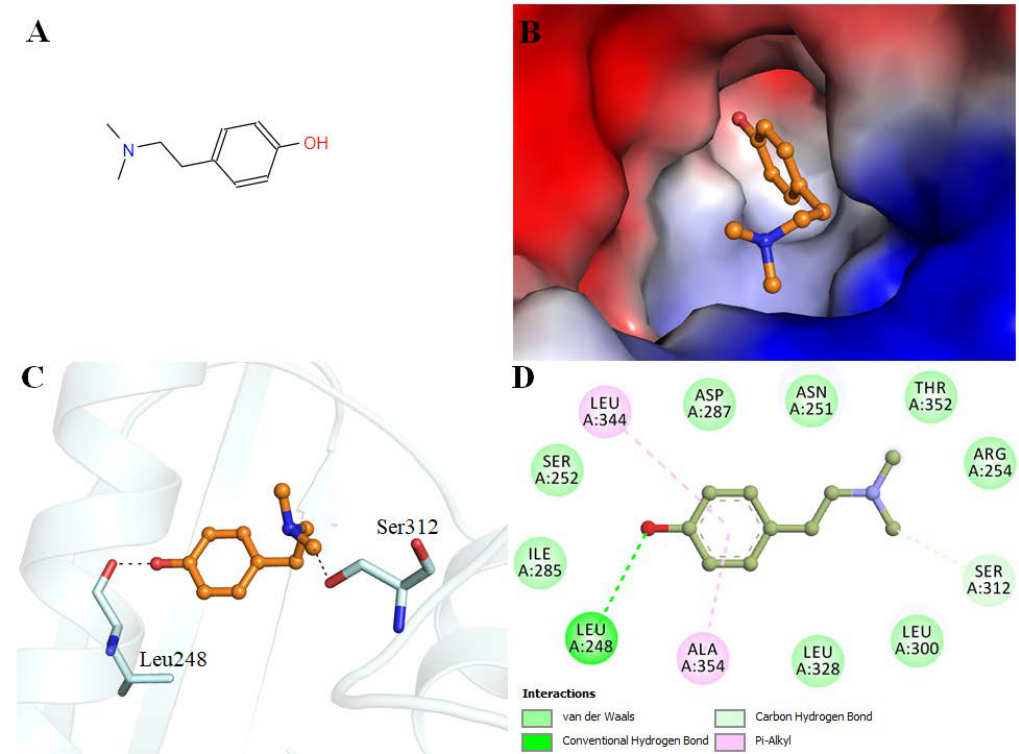
Figure 1. Interactions of hordenine with PDK3. ( A ) 2D representation of hordenine structure. ( B ) Surface view of PDK3 binding pocket occupied by hordenine. ( C ) Hordenine interacting with binding site residues of PDK3 is depicted in cartoon representation. ( D ) 2D structural representation of PDK3 residues interacting with hordenine.